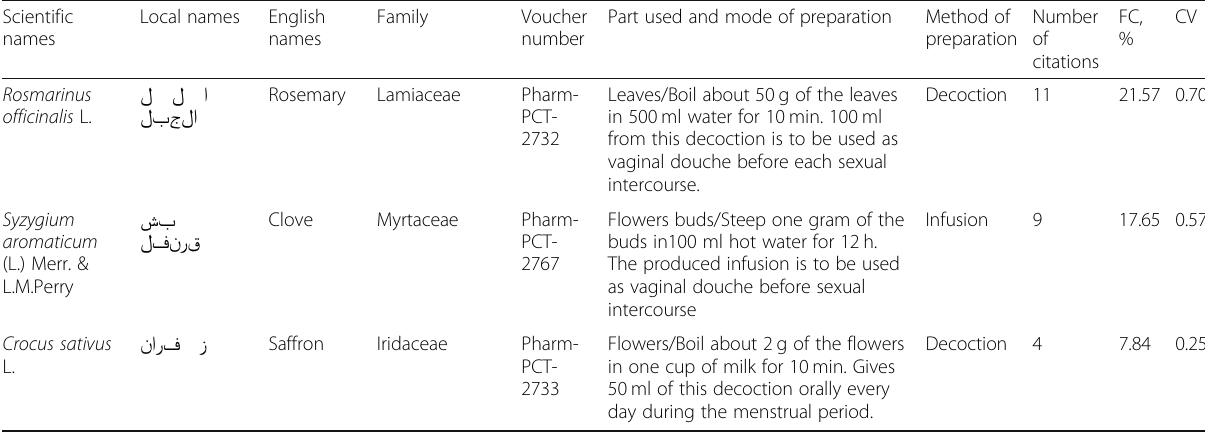
Table 2 The used herbals for the treatment of infertility in females, the plant ’ s parts used, Frequency of Citation (FC), Choice values, modes of administration and methods of preparation